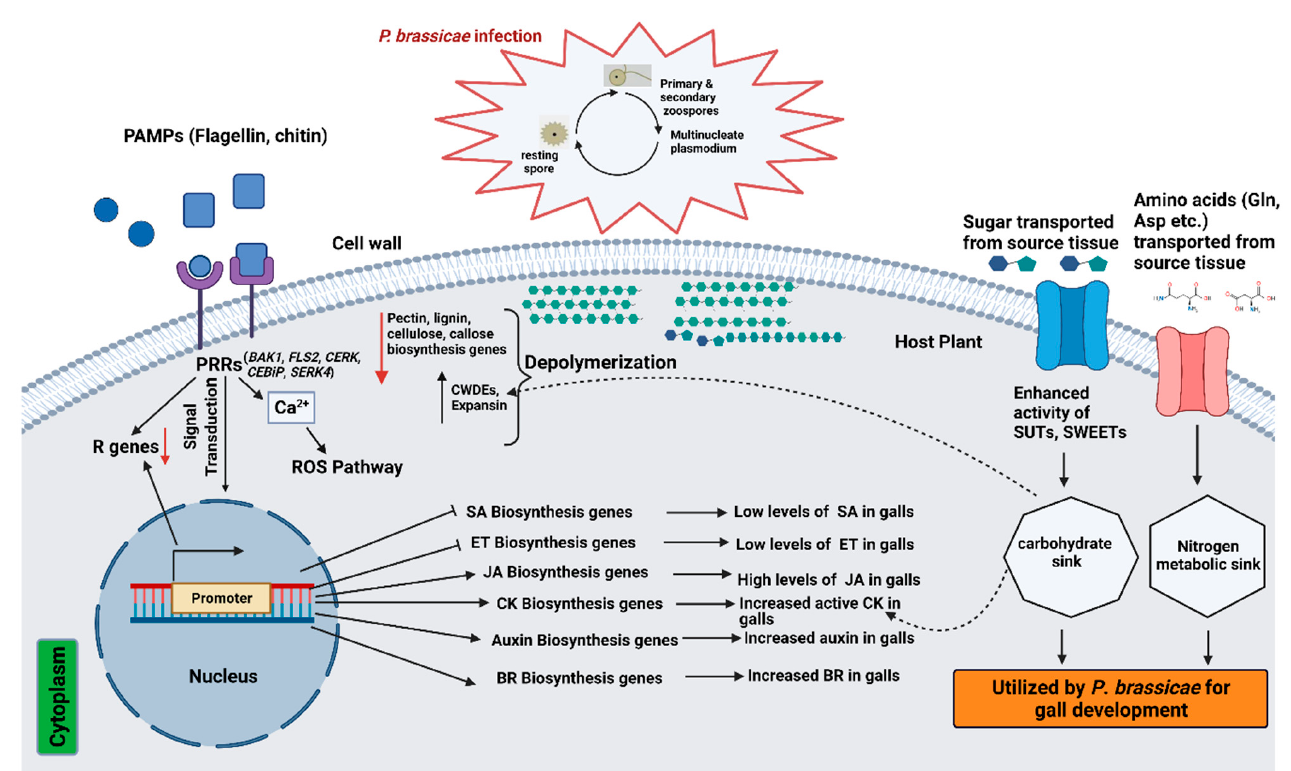
Figure 2. Schematic view of a model depicting metabolic and transcriptional changes happening in susceptible host after P . brassicae infection adopted and modified from Hasan et al. [263] with copy right permission (License Number—1236246-1) from Canadian Science Publishing and Copyright Clearance Center (www.copyright.com, Accessed on 16 June 2022).